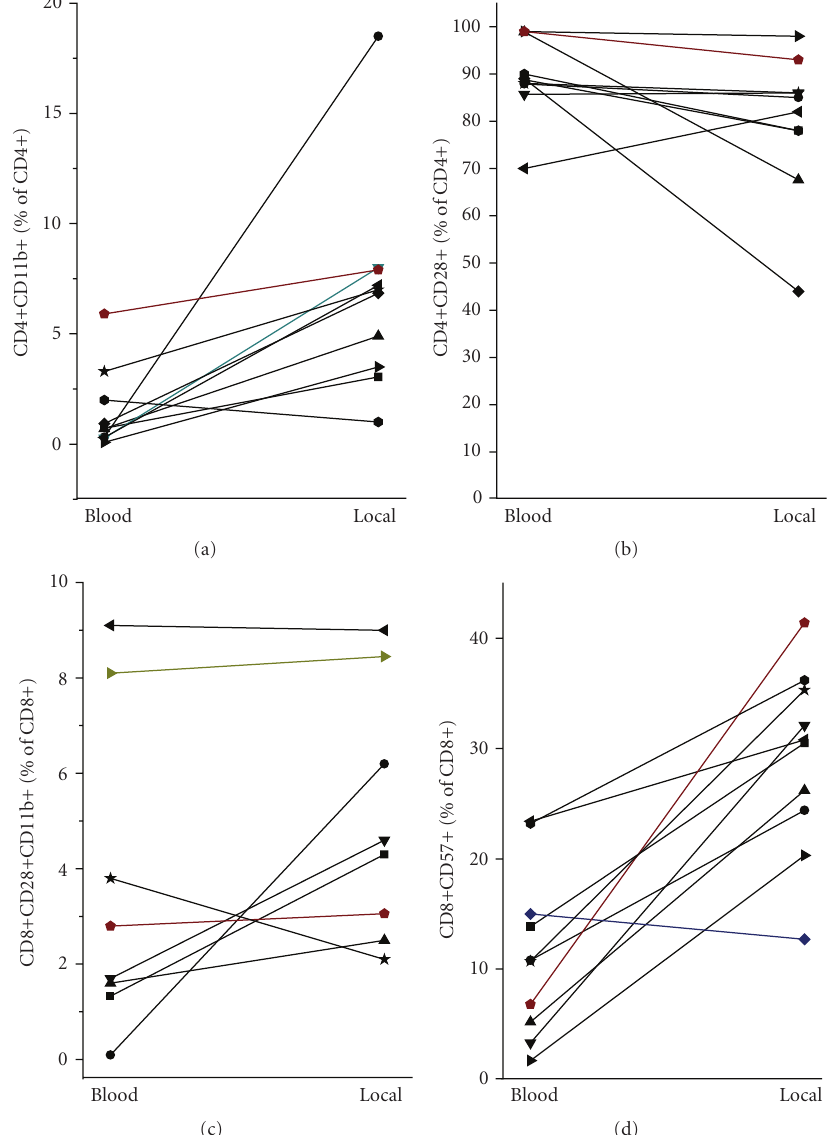
Figure 6: Characterisation of the infiltrated T cells: (a,b) compared to the peripheral blood, the cellular infiltrate (local) contained a higher percentage of CD4+CD11b+ cells, while CD28 − was lost (each pair of symbols corresponds to one patient). (c) For CD8+ cells, a small increase of CD8+CD11b+ cells in the cellular infiltrate was seen in the majority of patients, and (d) a considerable in increase in CD8+ expressing